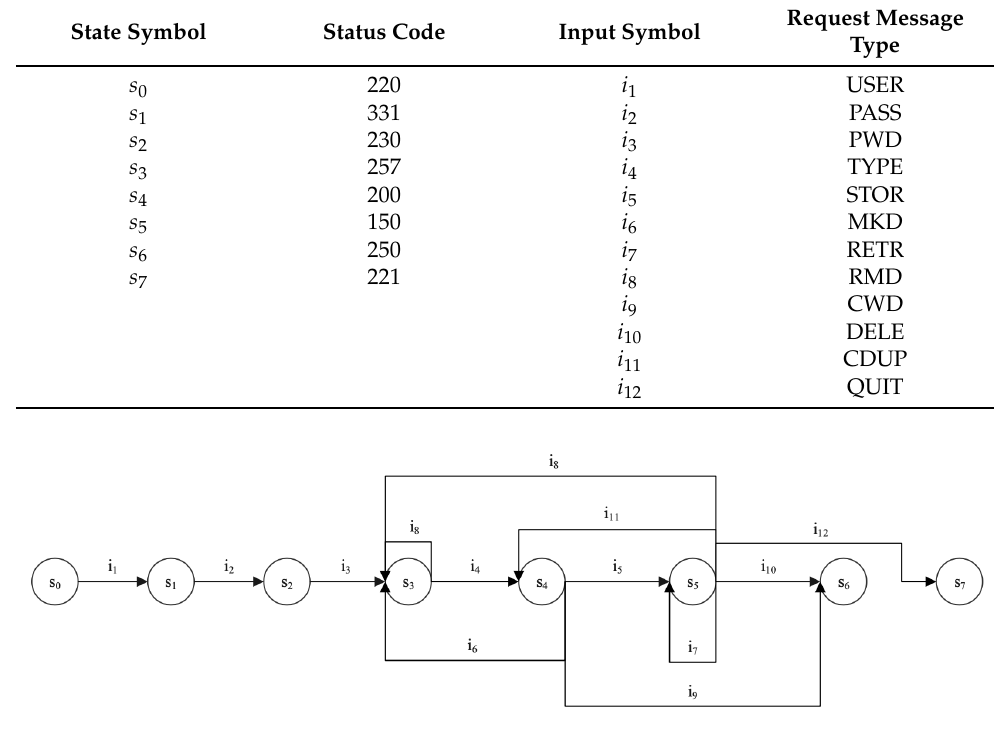
Figure 2. The SFSM of the